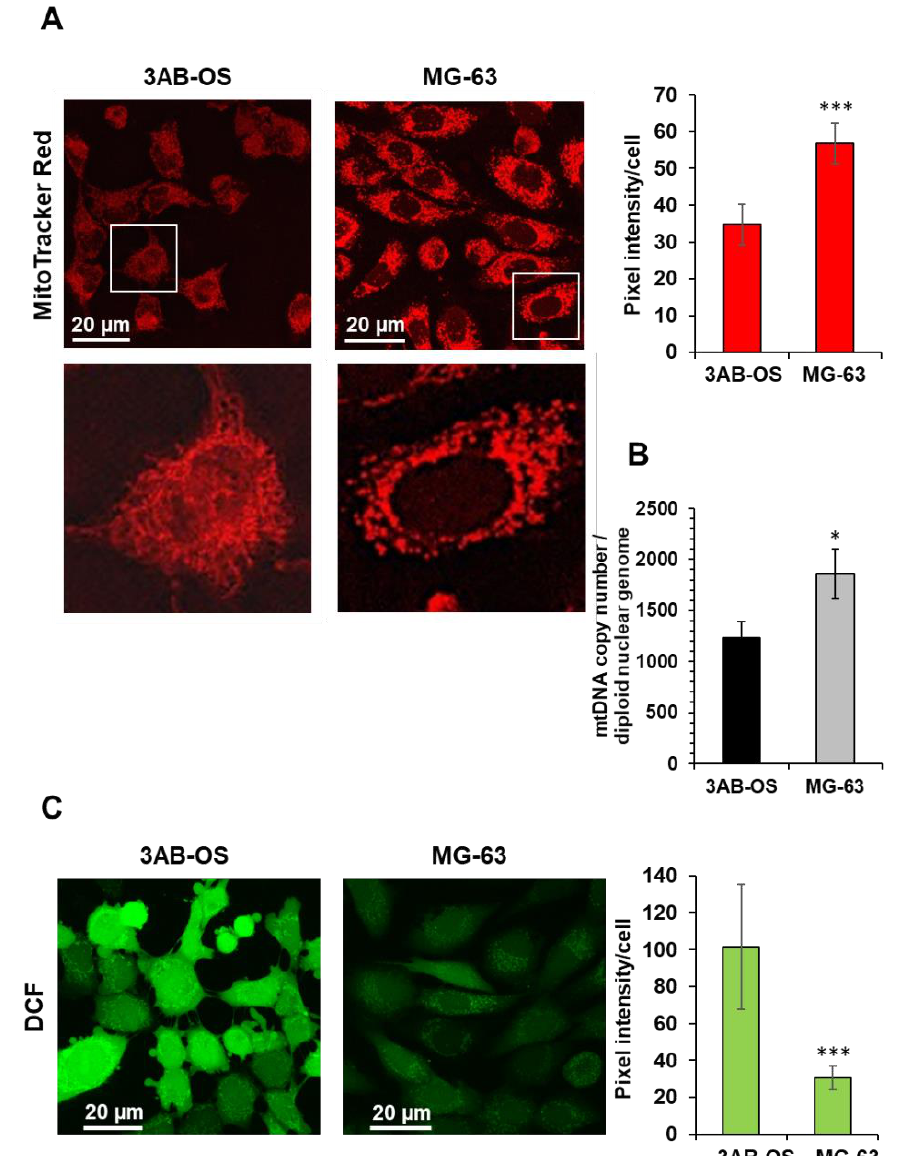
Figure 2. ( A ) Laser scanning confocal microscopy (LSCM) imaging of mitochondrial morpho-functional parameters in 3AB-OS and MG-63 cells by the fluorescent probe MitoTracker Red. Left panels show representative images and digital magnifications of the squared details. The histogram on the right shows statistical analysis of the MitoTracker pixel intensity per cell; values are means ± SD of three independent biological replicates; *** p < 0.001. Ten randomly chosen optical fields/sample each containing about 15 cells were analyzed by ImageJ. ( B ) mtDNA copy number of 3AB-OS and MG-63 cells assessed by q-RT-PCR; the bar histogram shows values normalized to the nuclear DNA. The values are means ± SD of three independent experiments; * p < 0.01. ( C ) LSCM imaging of cells treated with the reactive oxidant species probe dichlorodihydrofluorescein (DCF). Left panels show representative images. The histogram on the right shows statistical analysis of the DCF pixel intensity per cell, *** p < 0.001; values are means ± SD of three independent biological replicates analyzed as in ( A